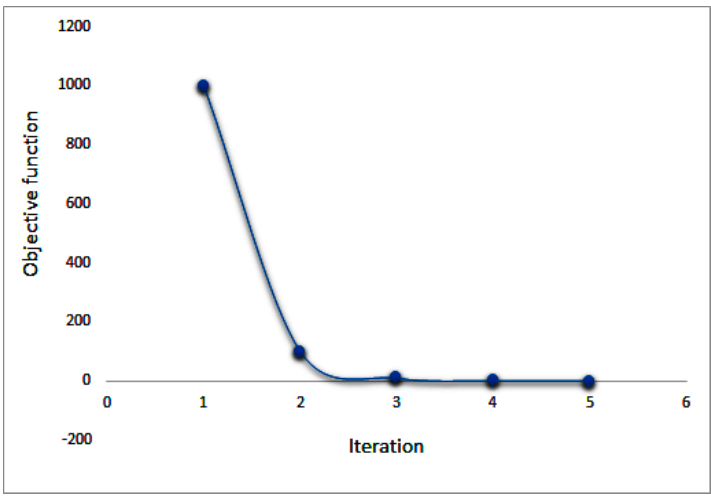
Figure 7. Objective function vs iteration for Jaya Algorithm.